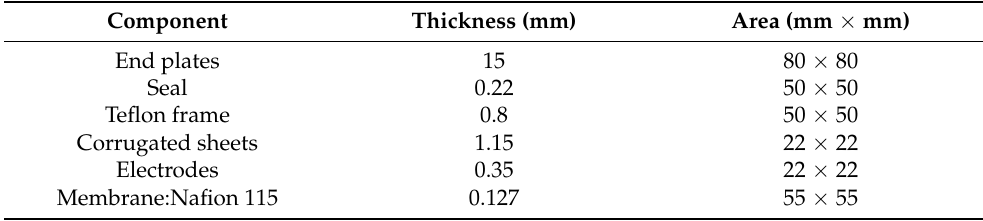
Table 1. Single-cell components dimensions.